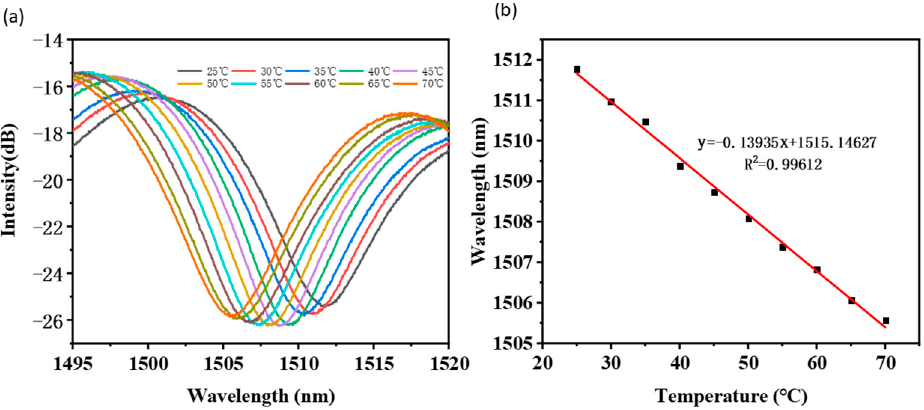
Figure 9. Testing on cross-sensitivity of temperature: ( a ) Wavelength shift and ( b ) its linear fitting result.